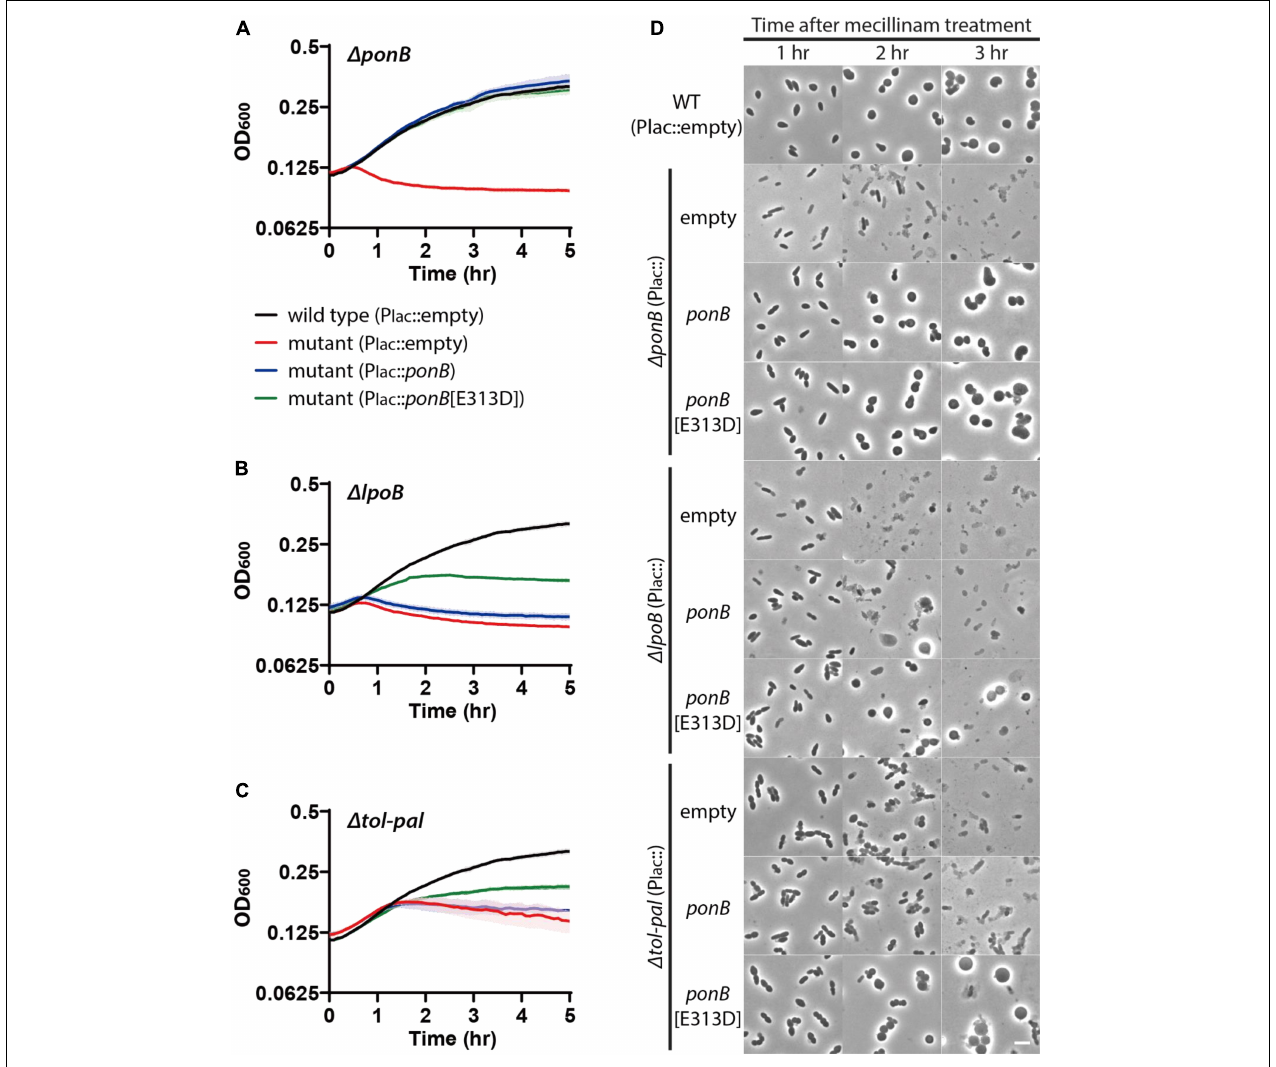
FIGURE 7 | Accelerated lysis of the tol-pal mutant upon mecillinam treatment is partially suppressed by production of LpoB-bypass PBP1b. (A–C) Lysis curves of (cid:49) ponB , (cid:49) lpoB , and (cid:49) tol-pal strains expressing wild-type ponB or the LpoB-bypass ponB allele upon treatment with 1 µ g/ml mecillinam. MG1655 (attHKpMT116, P lac :empty), WJ2[ (cid:49) ponB ](attHKpMT116)], WJ2 (attHKpSP23, P lac : ponB ), and WJ2 [attHKpSP24, P lac : ponB (E313D)] strains (A) were grown overnight in LB at 30 ◦ C. The overnight cultures were diluted to an OD 600 of 0.02 in LB supplemented with 1 mM IPTG to induce expression of ponB alleles and grown to an OD 600 between 0.2 and 0.3 at 30 ◦ C. The cultures were then diluted in LB supplemented with 1 mM IPTG and 1 µ g/ml mecillinam to an OD 600 of 0.1 and the optical density of each culture was measured as described in Figure 1 . The lysis phenotype of (cid:49) lpoB (B) and (cid:49) tol-pal (C) strain derivatives expressing either the ponB